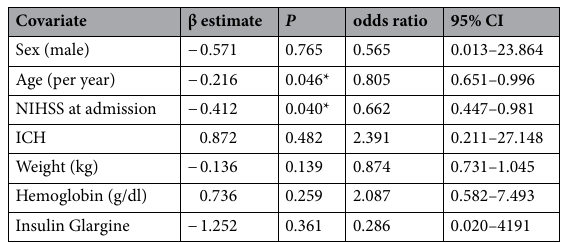
Table 3. Multivariable analysis for factors predicting AIS patients with good outcome. NIHSS National Institute of Health Stroke Scale, ICH intracerebral hemorrhage. *Statistical